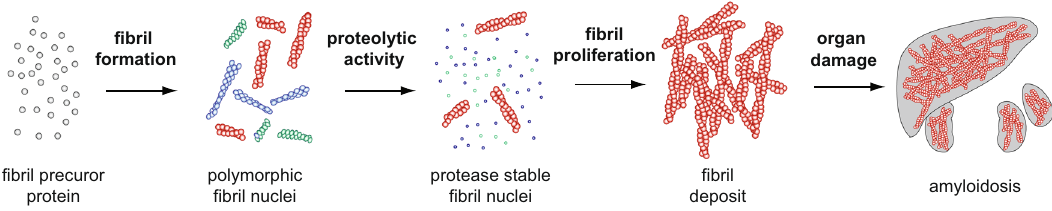
Fig. 6 Schematic representation of the proteolytic selection mechanism. Proliferation and subsequent organ deposition of proteolytically selected pathogenic fi bril morphologies. The protease unstable morphologies have been depicted in blue and green while the protease stable morphology is shown in